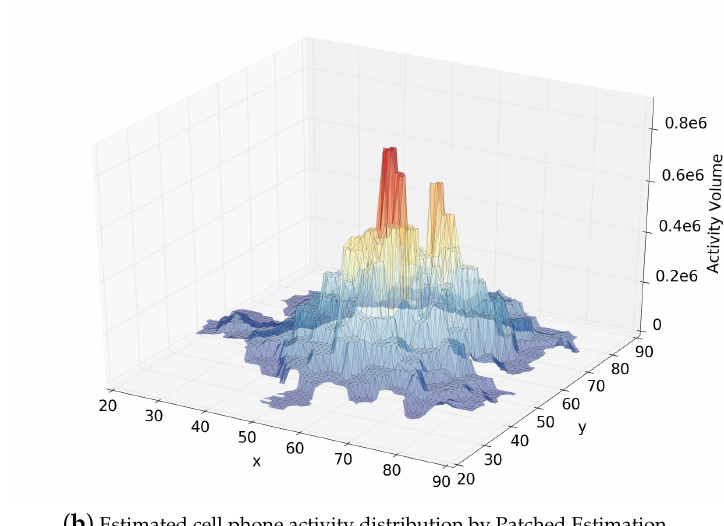
( b ) Estimated cell phone activity distribution by Patched Estimation.